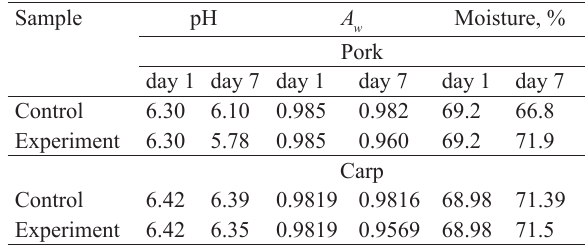
Table 7 Functional and technological indicators of pork and carp